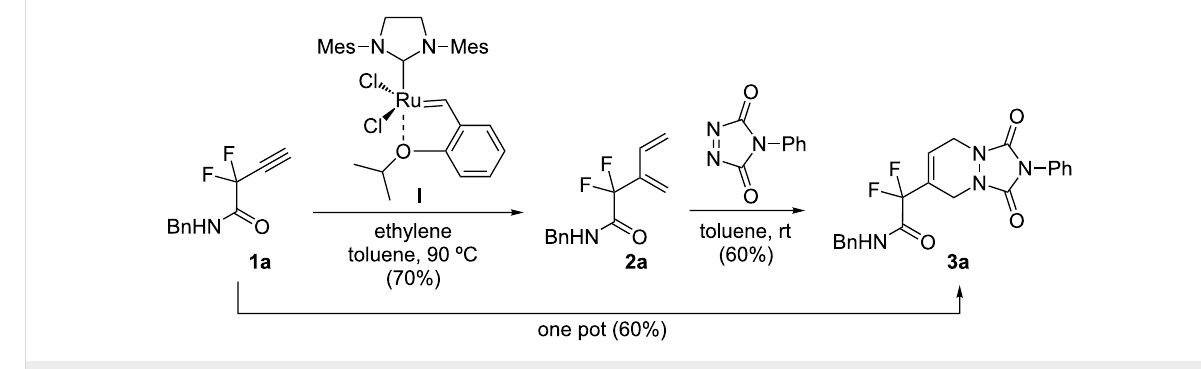
Table 1: Preparation of compounds 3 by one-pot CEYM–Diels–Alder reaction of substrates 1 (method A).